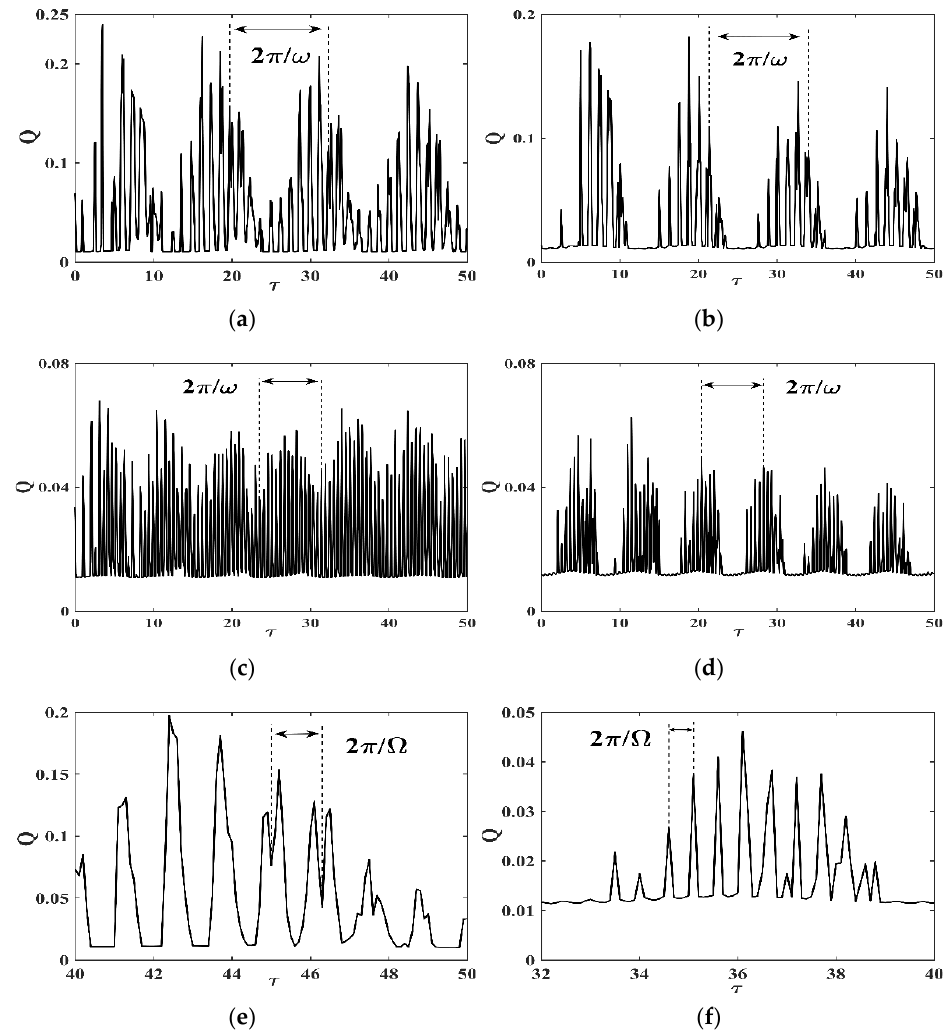
τ : Figure 3. Relationship curve between response amplitude Q and τ : ( a ) ω = 0.5, Ω = 5, α = 0.96, F = 0.123;